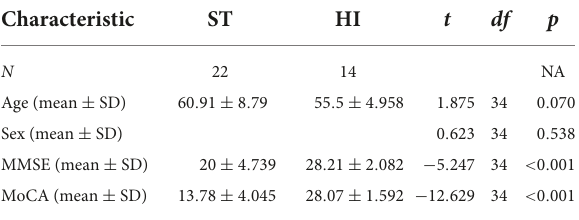
TABLE 1 Demographic data of the